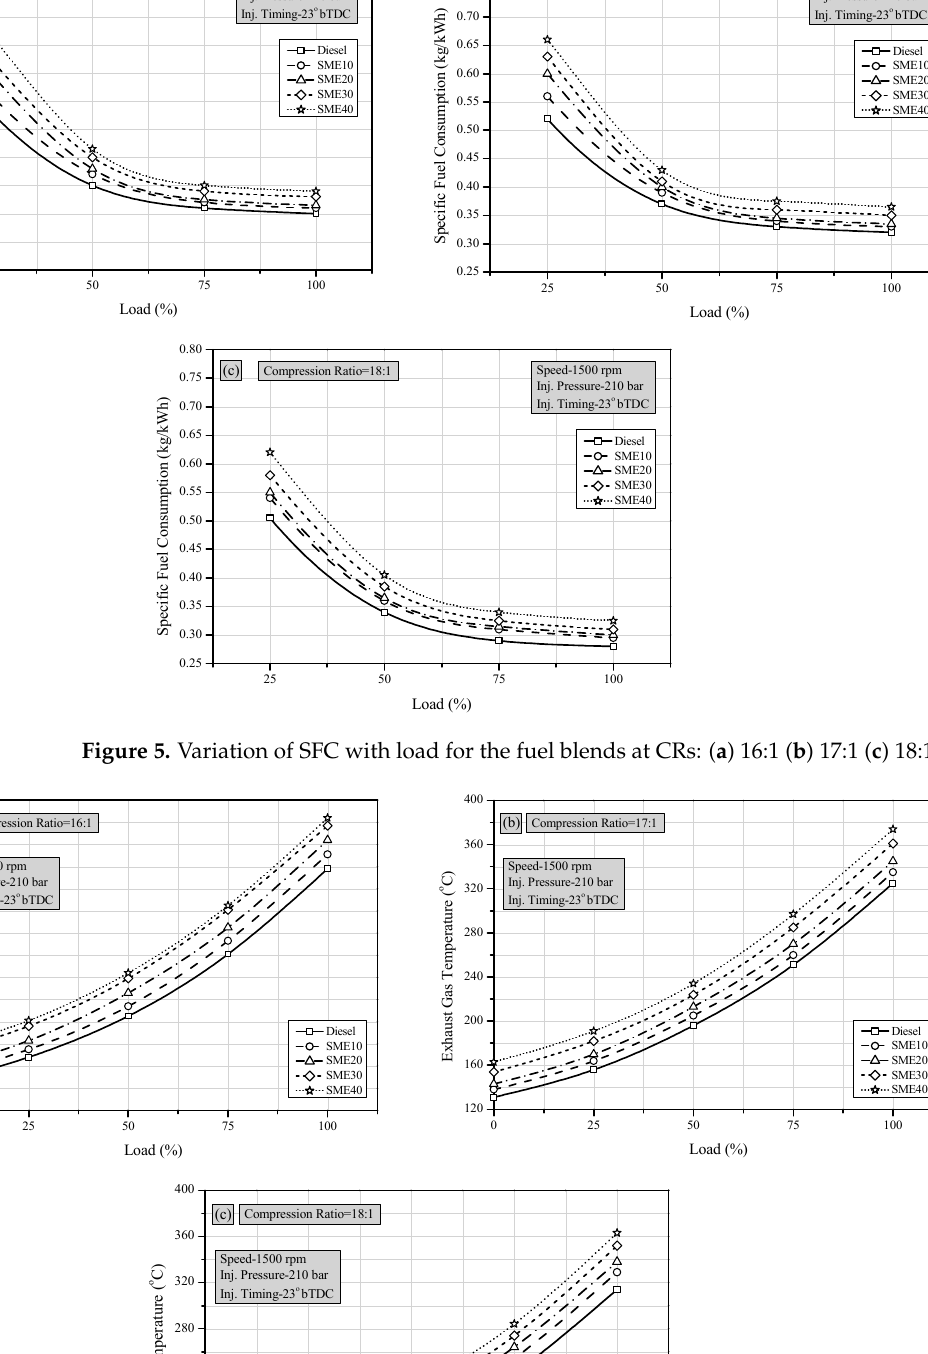
[56]. CR 18:1 resulted in the lowest SFC of 0.28 kg/kWhr, 0.295 kg/kW-hr, 0.3 kg/kWhr, 0.31 kg/kWhr, 0.33 kg/kWhr for diesel, SME10, SME20, SME30 and SME40, respectively.